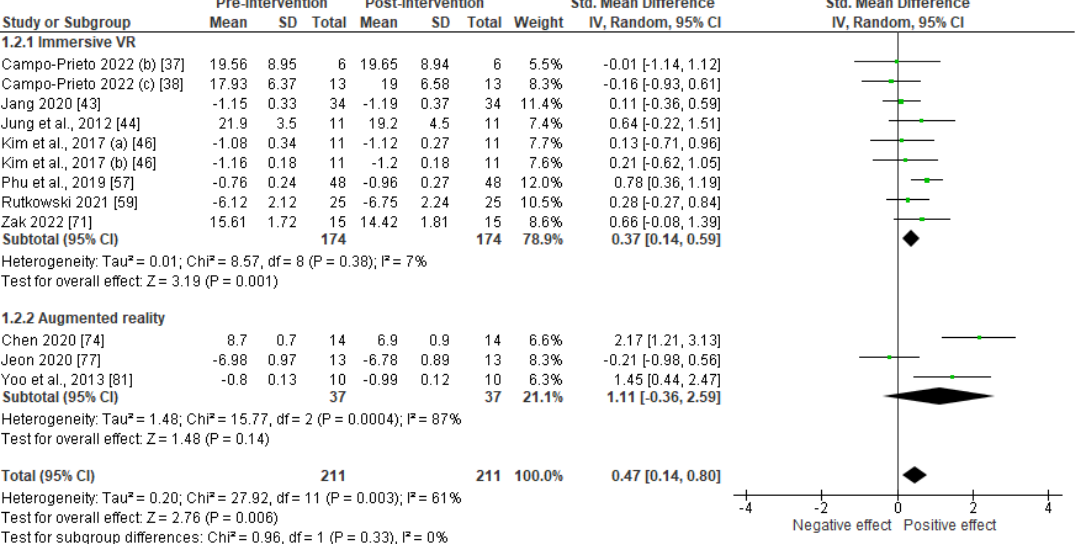
Figure 3. Forest plot of effects of intervention using immersive technologies on gait speed.